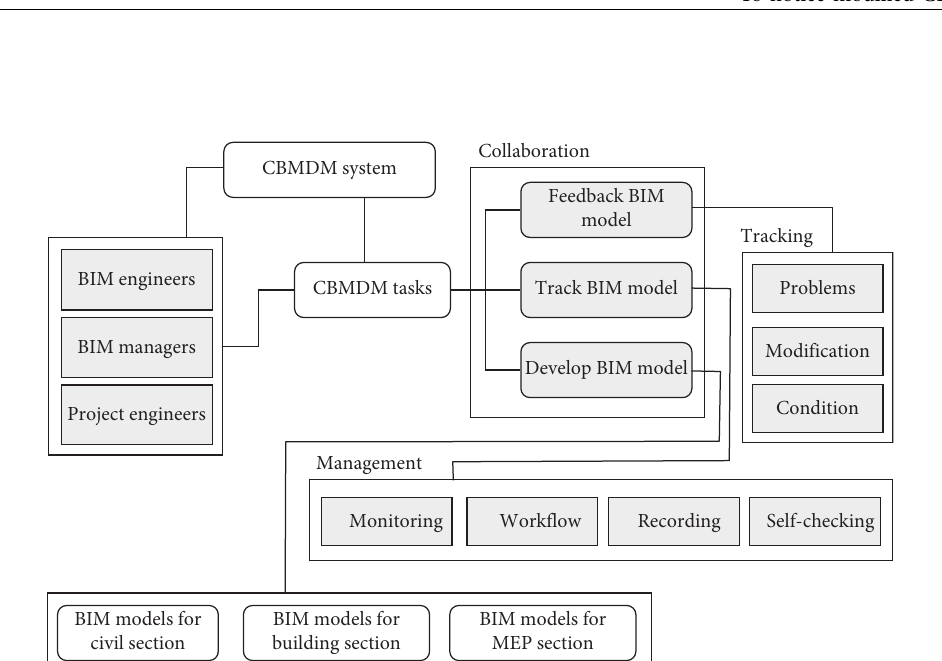
Figure 1: The concept for the proposed CBMDM